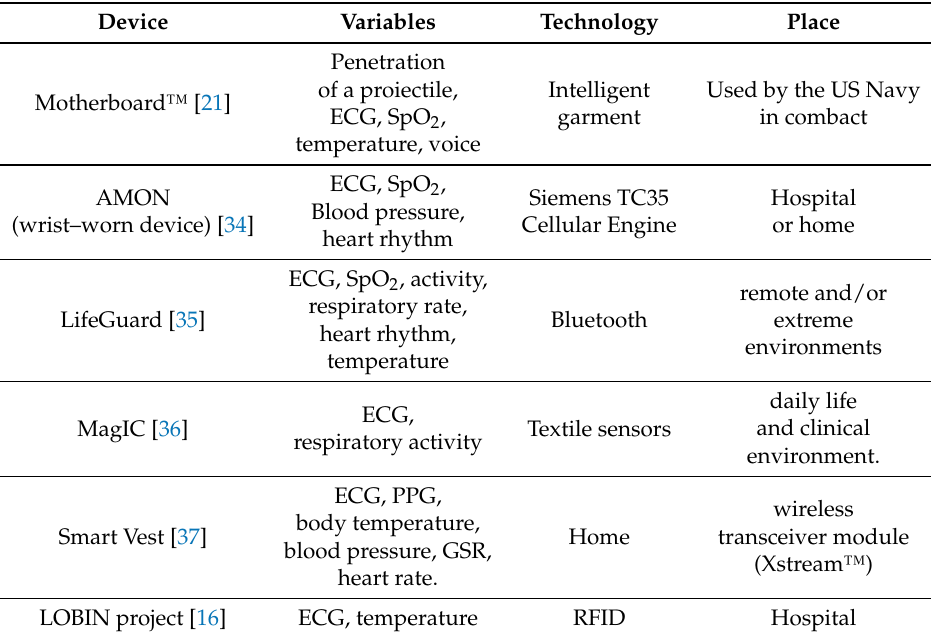
Table 1. Wearable medical devices to measure vital